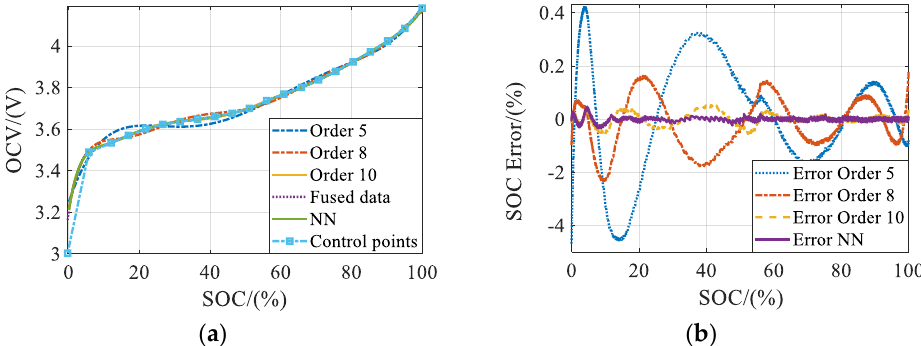
Figure 6. ( a ) Comparison of OCV fitting results. ( b ) Comparison of OCV fitting absolute error.